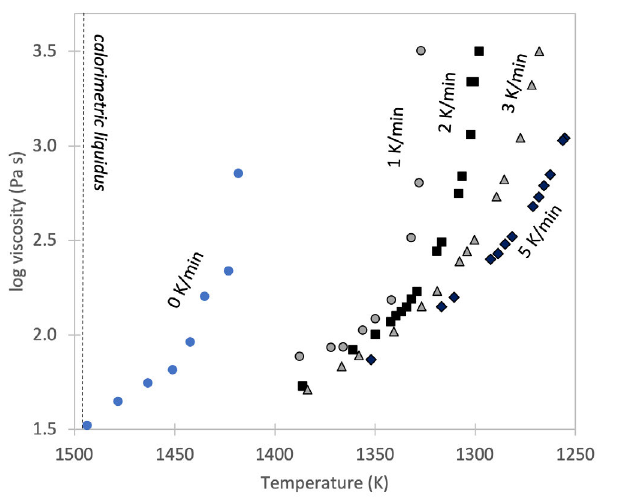
Figure 9: Nyiragongo viscosity data from Giordano et al. [2007] compared to our data from Figure 10. Blue points are the average apparent viscosities for each subliquidus experiment.